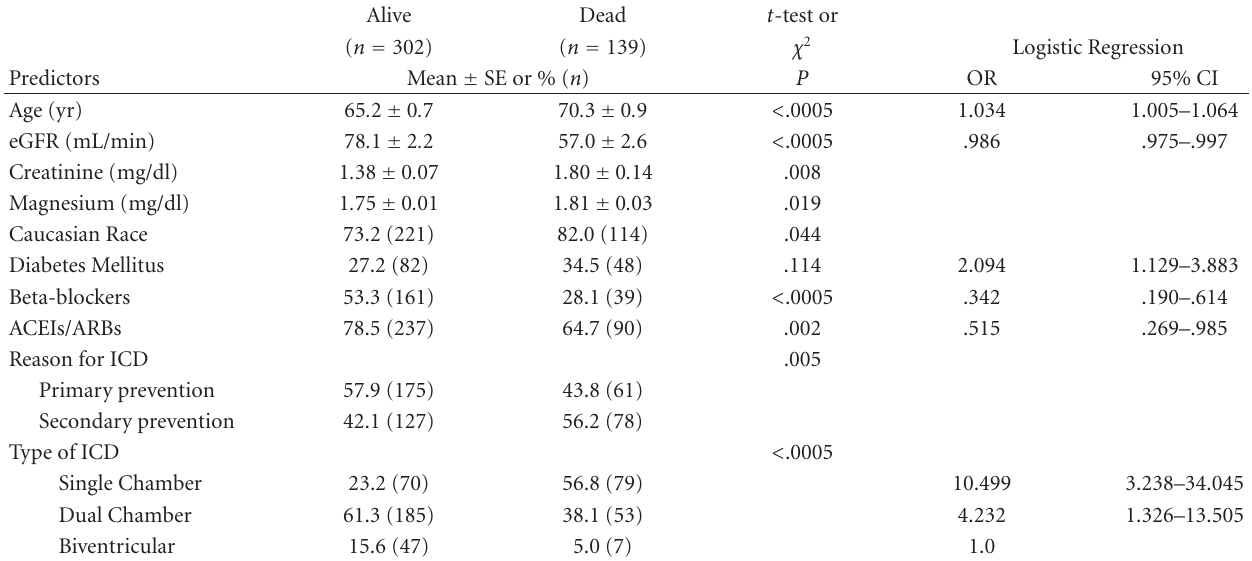
Table 2: Mortality Predictors in Univariate and Multivariate